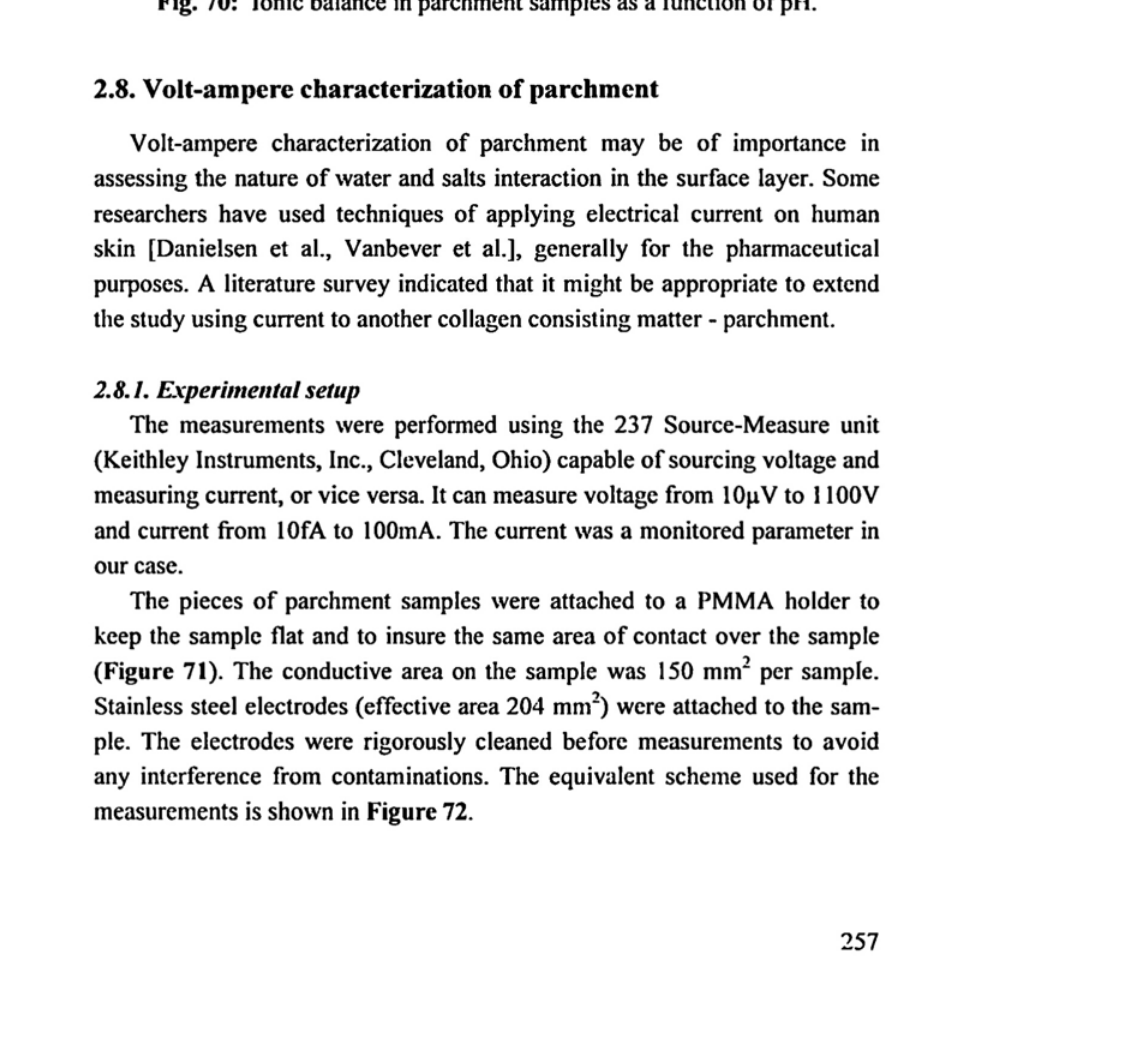
Fig. 70: Ionic balance in parchment samples as a function of